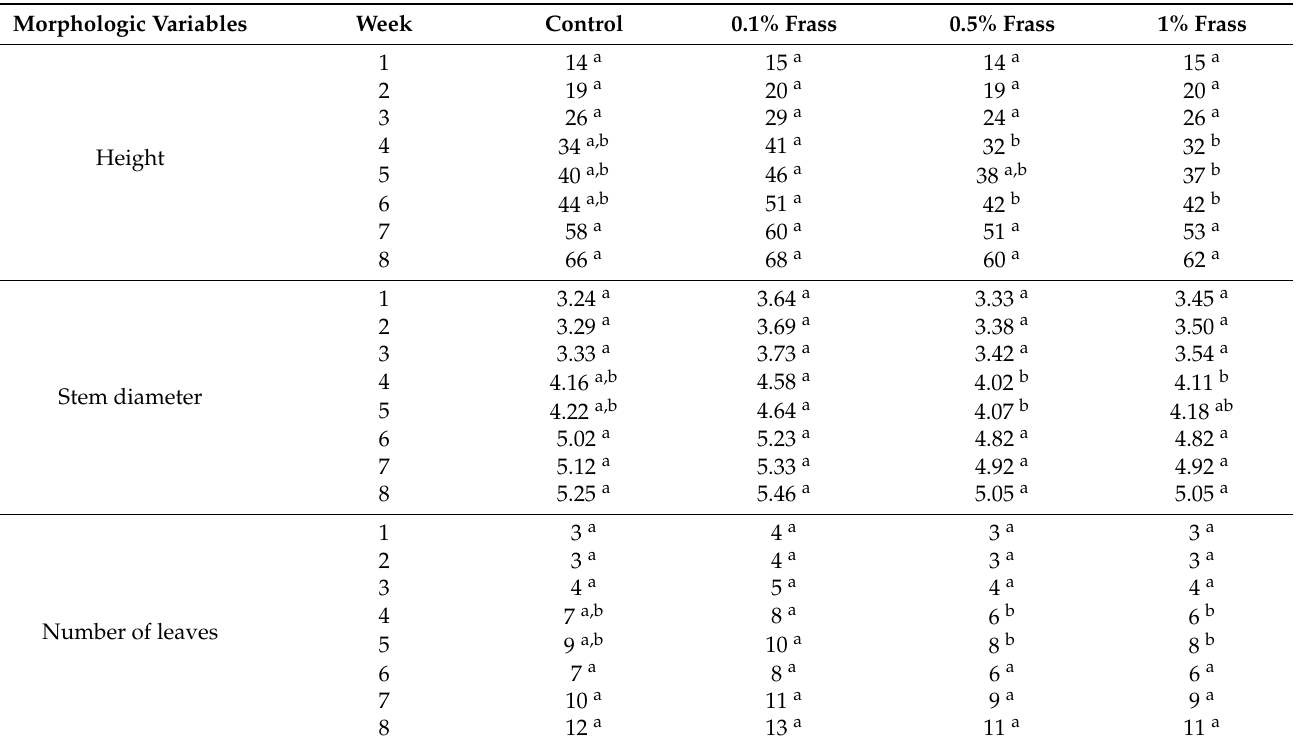
Table 1. Morphological response of tomato plants to the addition of cricket Frass to the cultivation